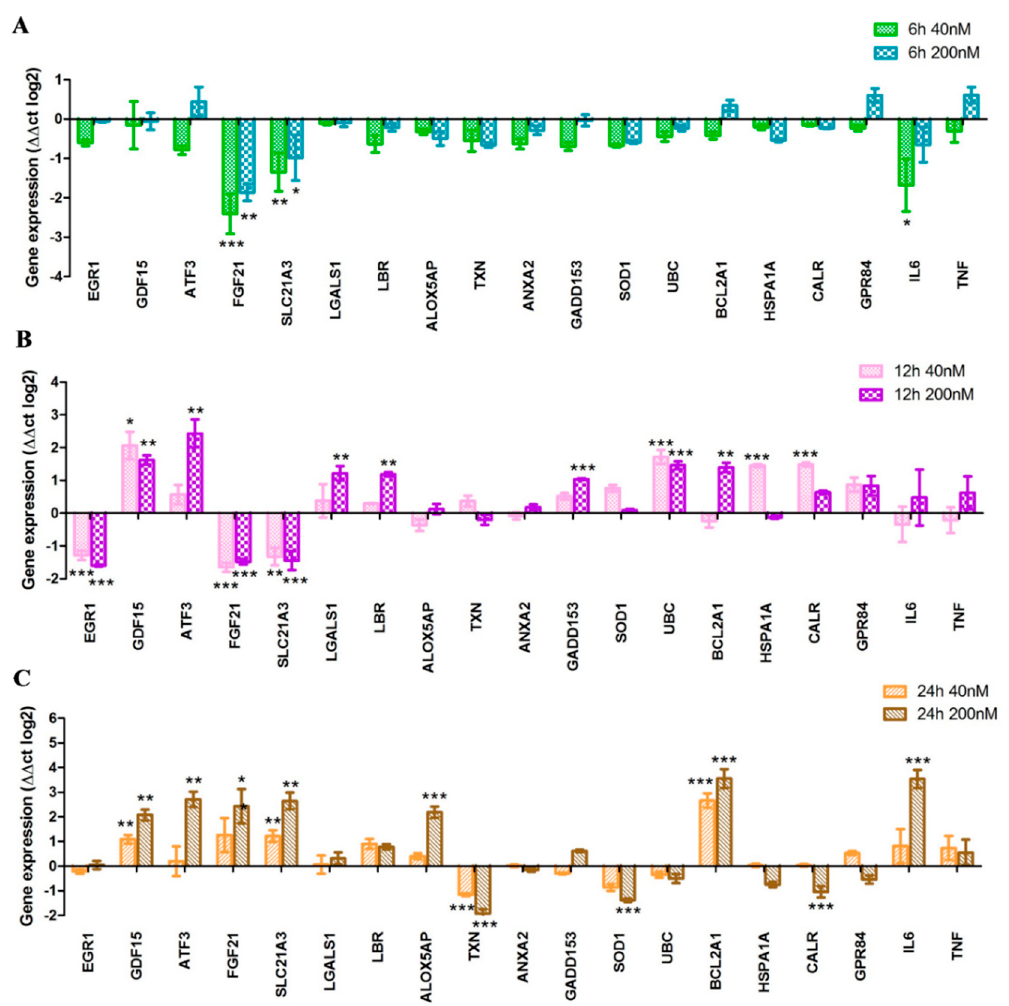
Figure 3. The expression of genes associated with drug induced cytotoxicity has been studied by quantitative real-time PCR after treatment with 40 nM or 200 nM DU385 compound for 6 h ( A ), 12 h ( B ), and 24 h ( C ), as described in Section 4.6 Materials and Methods. * p < 0.05, ** p < 0.01, *** p <